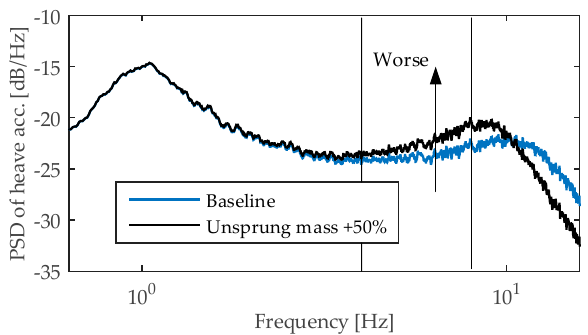
Figure 1. Effect of 50% increase in the unsprung mass on the vertical acceleration of vehicle body. The resultant worsening of ride comfort is reflected by higher Power Spectral Density in the frequency range 4–8 Hz, where the driver is more sensitive to vertical accelerations.